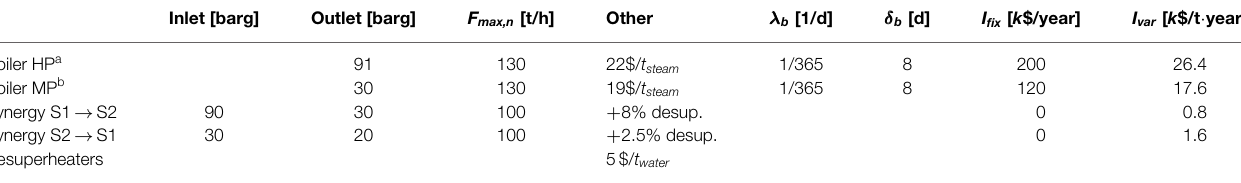
TABLE 3 | Proposed investments to replace CB boilers